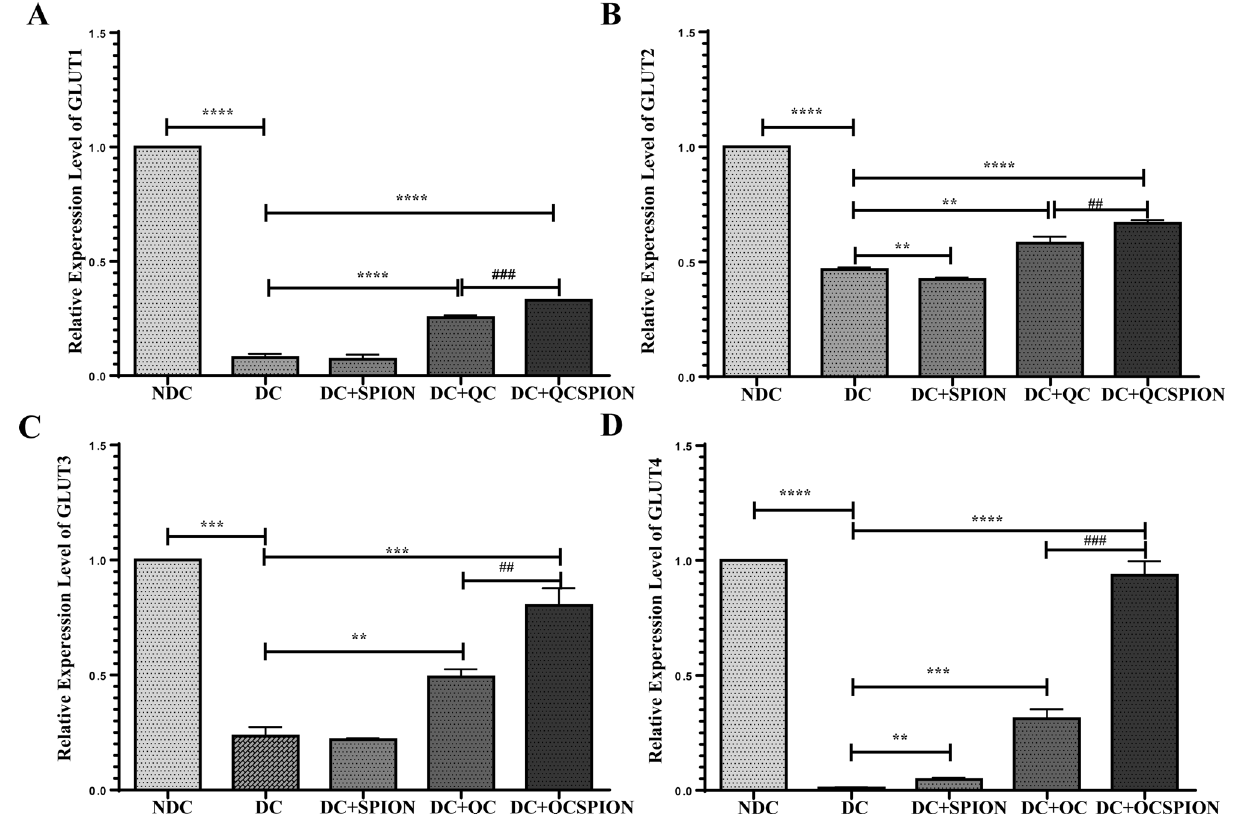
Figure 3. Effect of QC and QCSPIONs treatment on mRNA levels of glucose transporters. ( A ) GLUT1, ( B ) GLUT2, ( C ) GLUT 3, ( D ) GLUT4 in the hippocampus of diabetic rats. Data are mean with SEM (n = 5 per group). **P < 0.01, ***P < 0.001 and P < 0.0001 vs DC group (One-way ANOVA, Tukey’s multiple comparison tests). ## P < 0.01, ### P < 0.001 vs QCSPION group. NDC non-diabetic control, DC diabetic control, DC + SPION diabetic treated with superparamagnetic iron oxide nanoparticle, DC + QC diabetic treated with quercetin, DC + QCSPION diabetic treated with quercetin-conjugated superparamagnetic iron oxide nanoparticle, GLUT glucose transporter.